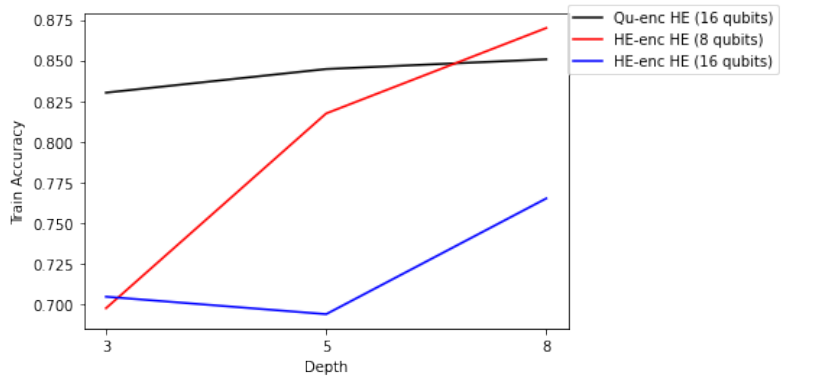
Figure 5. Comparison between the qubit-encoding and HE-encoding methods at different depth